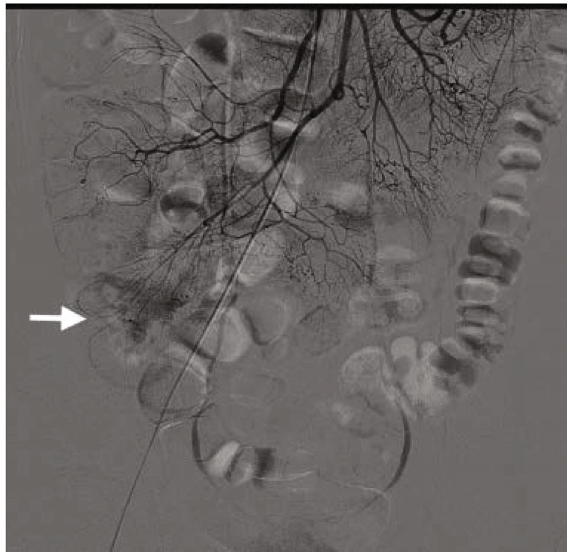
Figure 6: Digital angiography showing a contrast extravasation (arrow) from one of the branches of the superior mesenteric artery, con fi rming a bleeding Meckel ’ s